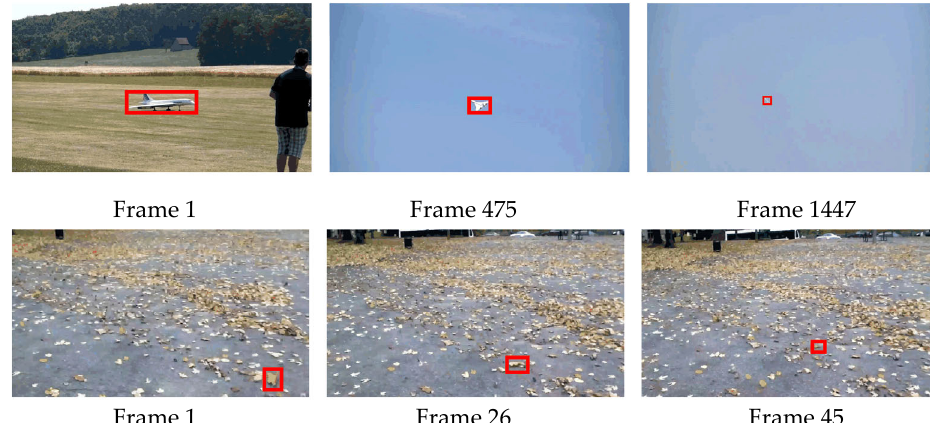
Figure 9. Tracking failure scenarios.